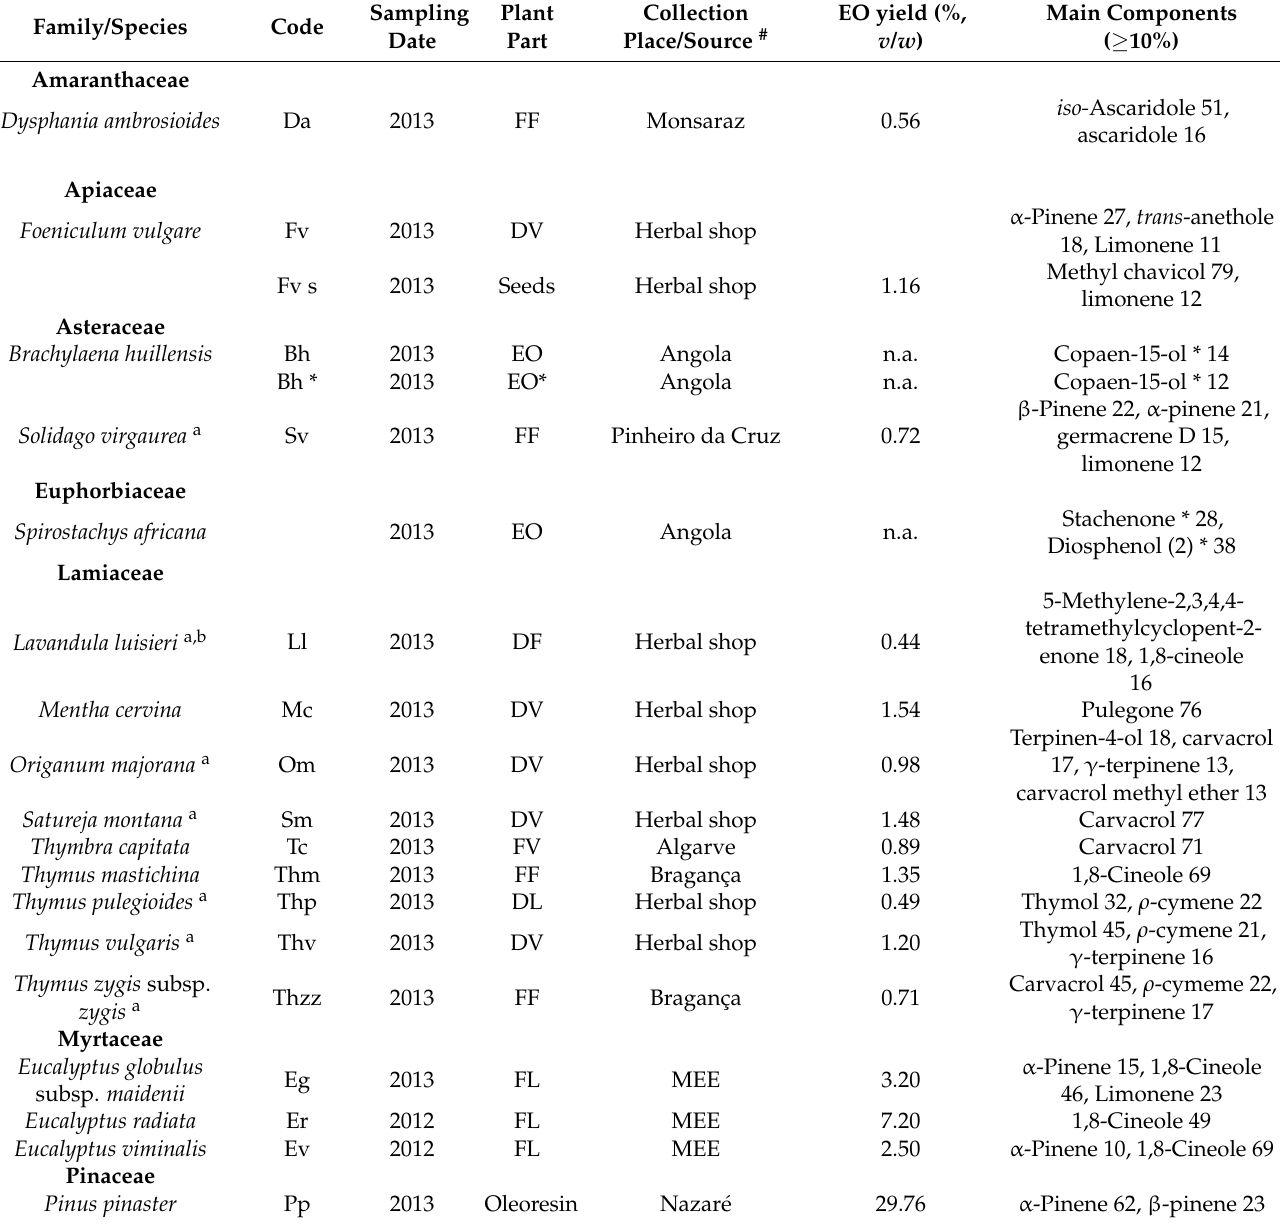
Table 3. List of the evaluated species, sampling year, plant part used for hydrodistillation, plant source, essential oil yield and main components ( ≥